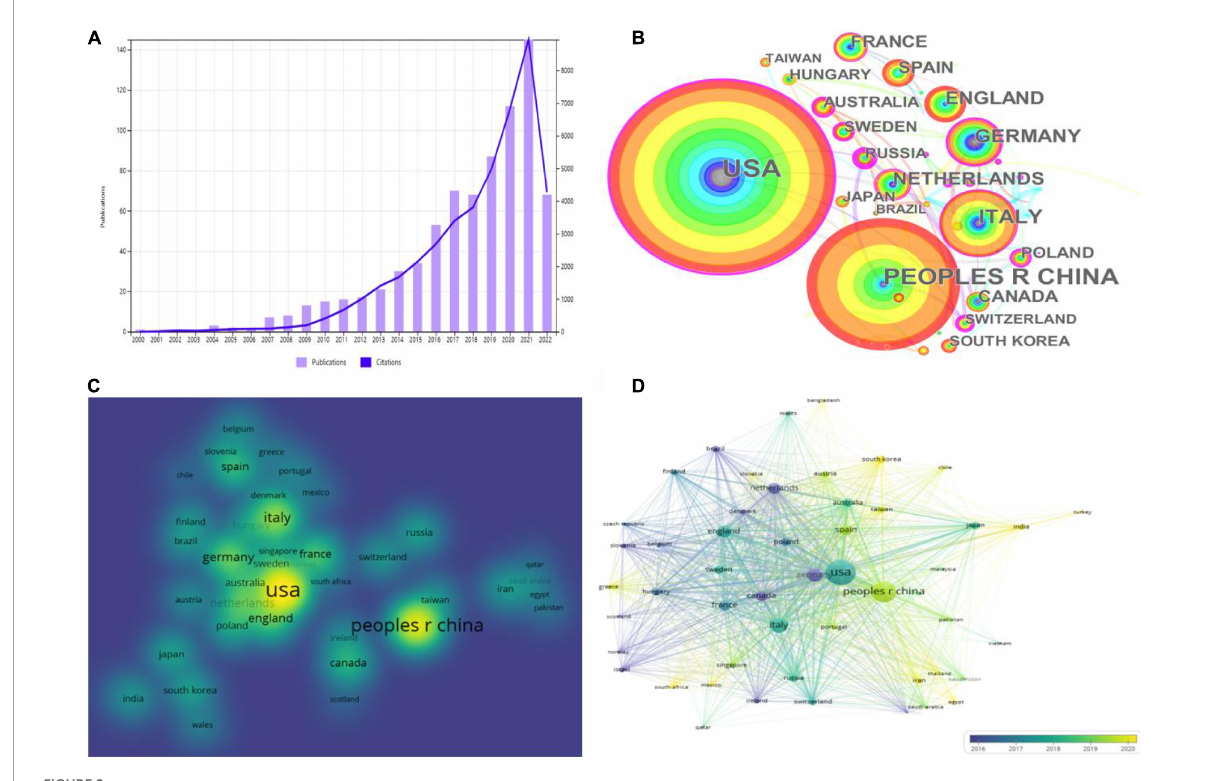
FIGURE2 Platelet exosomes in global publications. (A) Annual publications and citations of platelet-related exosome studies worldwide. (B) CiteSpace-based web visualization of article distribution by country. (C) VOSviewer-based density map distribution of articles by country. (D) VOSviewer-based chronological order of